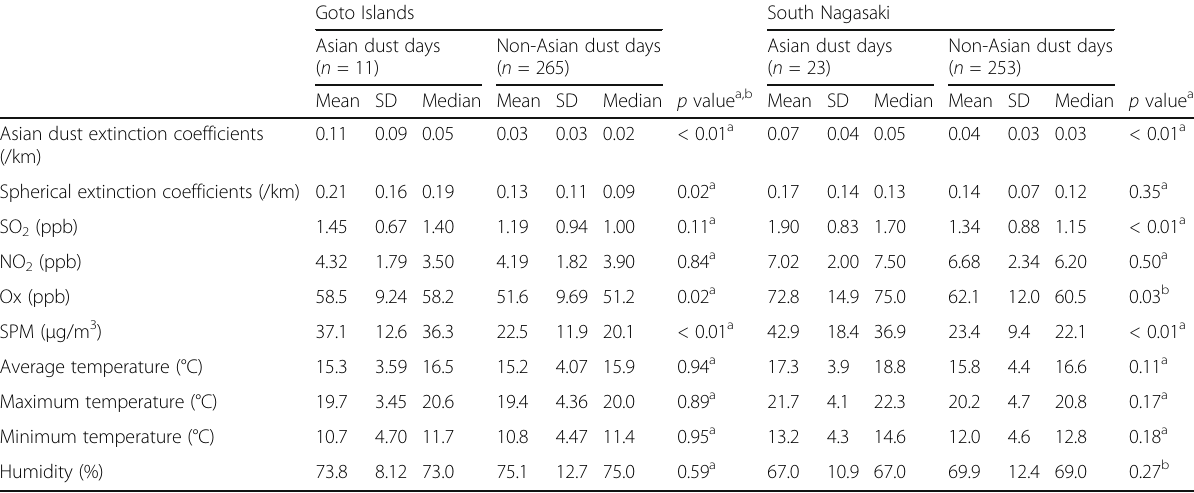
ical symptoms. PEFRs were measured in 5996 days in the Goto Islands and 13,613 days in south Nagasaki. The Table 2 Summary of data on Asian dust, other air pollutants and meteorological factors (March 2014 – May 2016) Goto